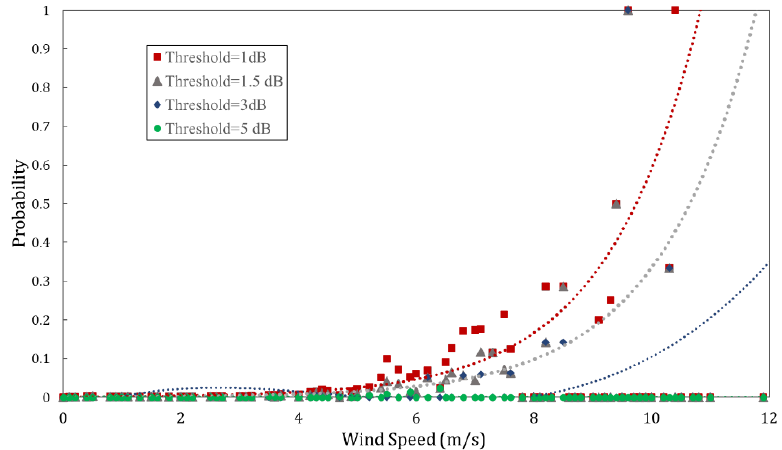
Figure 18. Probability of misalignment and realignment events due to wind gusts over the measurement period, at different RSSI shift thresholds.